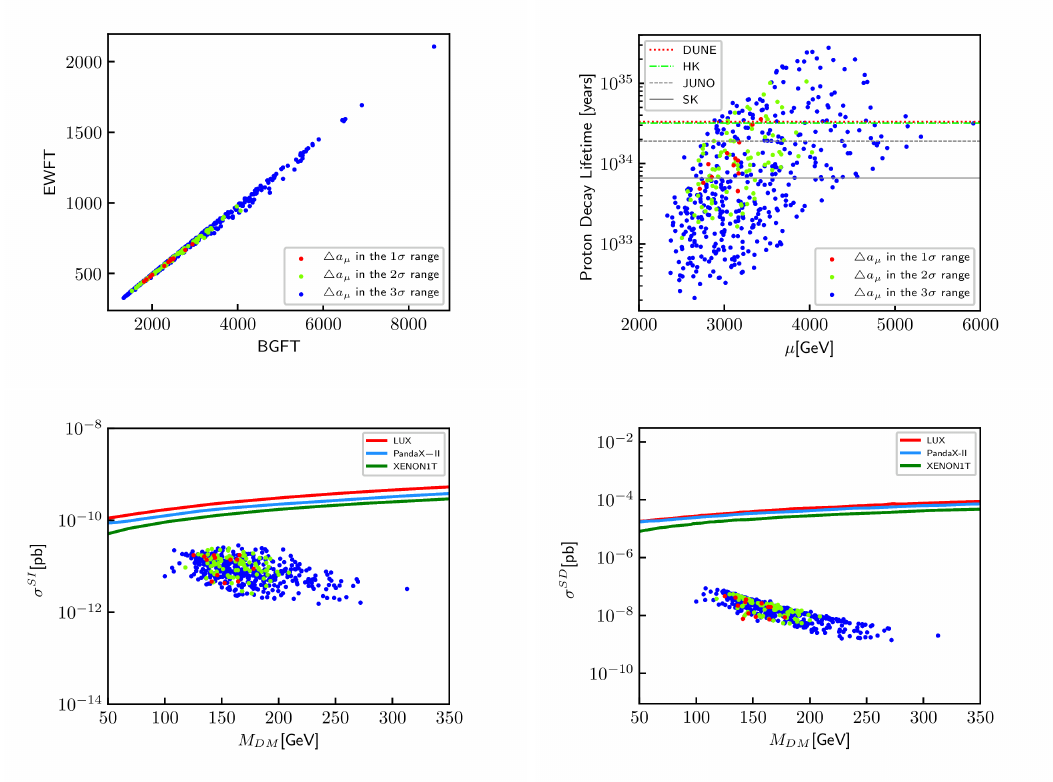
Figure 7 . Same as figure 2, but for scenario (3) with bino-wino mixture dark matter. range of ∆ a combine , which predict τ . 3 . 1 × 10 34 year, can be tested by future DUNE, p µ Hyper-Kamiokande proton decay